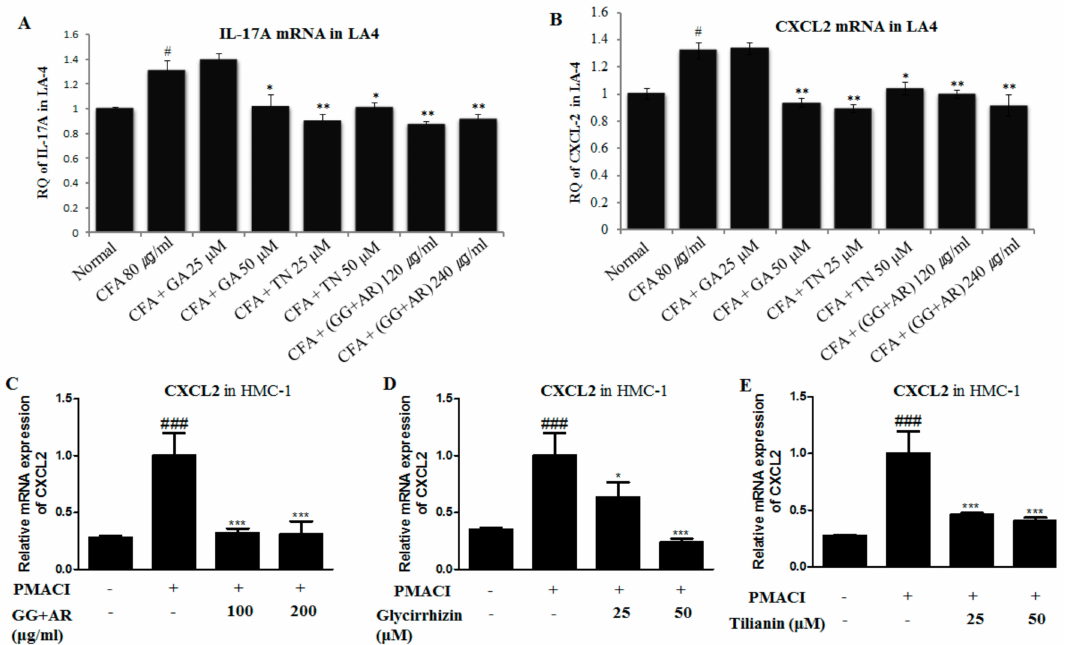
Figure 8. Inhibitory e ff ect of GG plus AR, GA, and TN on CXCL2, IL-17A mRNA gene expression in vitro (LA4 and HMC-1 cell line). LA4 cells were pre-treated with of vehicle, GG plus AR (120 or 240 µ g, GA, TN for 30 min prior to the addition of 80 ug / mL of CFA for 6 h. HMC-1 cells were pre-treated with of vehicle, GG plus AR (100 or 200 µ g / mL), GA, TN for 30 min prior to the addition of 40 nM of PMA plus 1 µ M of A23187 (PMACI) for 6 h. The cells were seeded 16 h before RNA preparation. IL-17A ( A ), CXCL2 ( B ) mRNA expression levels in LA4 and e ff ects of GG plus AR ( C ), GA ( D ), and TN ( E ) on CXCL2 mRNA gene expression were measured using quantitative real-time PCR. The statistical significance of di ff erences between control and treatment groups were assessed by ANOVA and Duncan’s multiple comparison test. The data shown represent mean ± SD of three independent experiments. # P < 0.05 and ### P < 0.001 vs. the normal control group, * P < 0.05, ** P < 0.01, and *** P < 0.001 vs. CFA-treated or the PMACI-treated